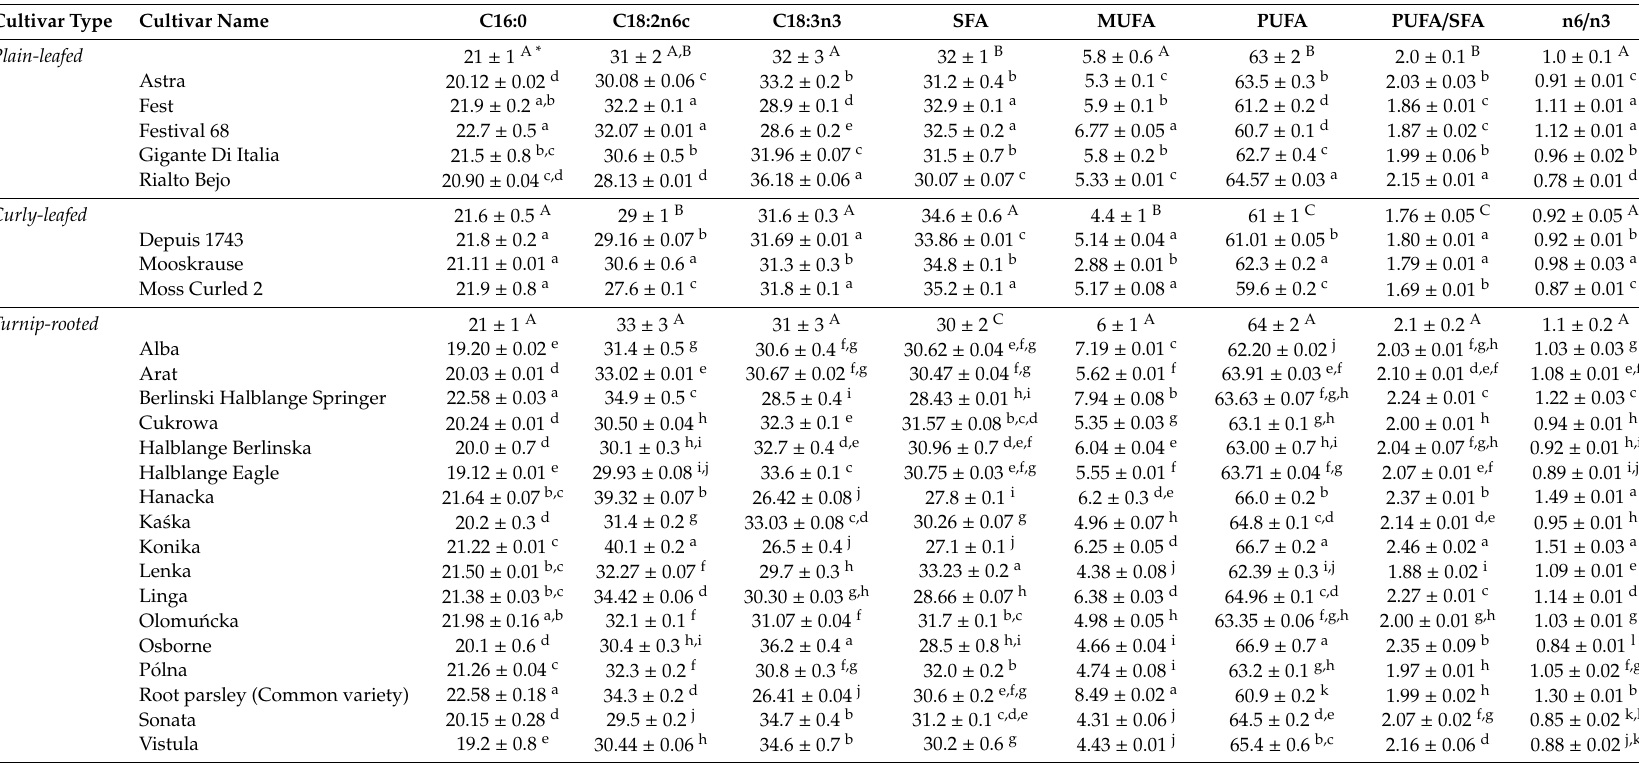
Table 5. Main fatty acids (%) identified in the studied parsley leaves samples, fatty acid groups, and relative ratios (mean ±